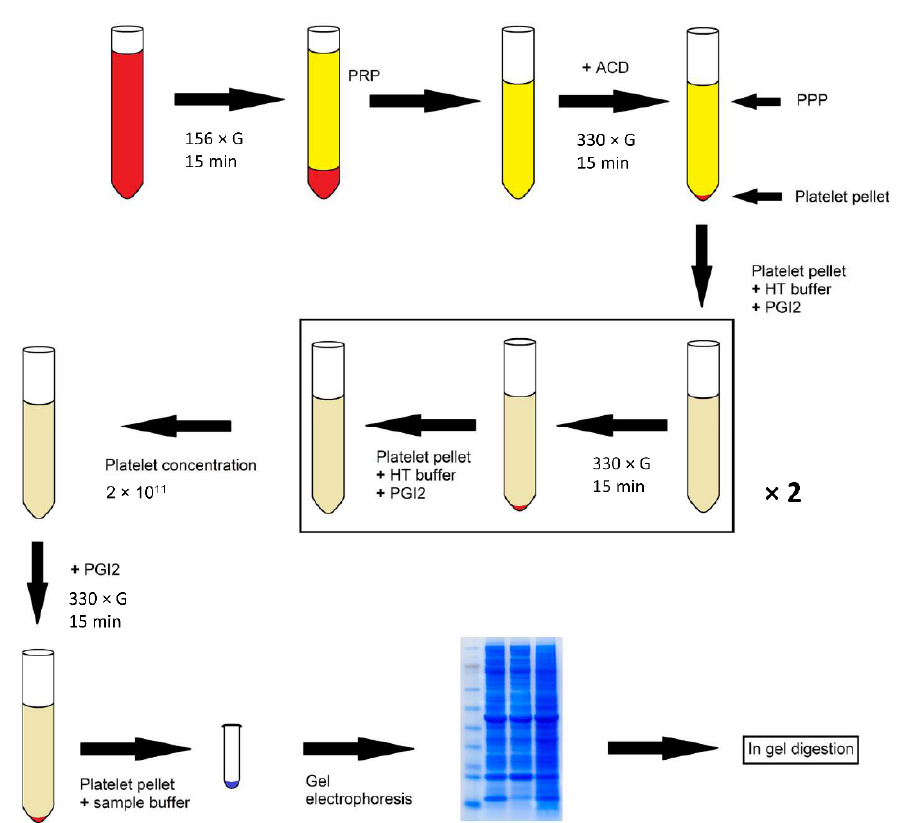
Figure 1. Schematic representation of the workflow. Blood was collected in citrated tubes. Platelet-rich plasma (PRP) was prepared by centrifugation. ACD was added, after which a platelet pellet was obtained by centrifugation. The pellet was resuspended in Hepes-Tyrode (HT) buffer (pH 6.5). Prostacyclin (PGI2) was added and a pellet was obtained by centrifugation. This was repeated once. Platelets were resuspended in HT buffer (pH 7.3). Tubes were centrifuged in the presence of PGI2. The pellet was resuspended in sample buffer, heated for 5 min at 99 ◦ C and stored at − 20 ◦ C. Proteins were separated with electrophoresis (125 V) in precast gradient gels. In-gel digestion was performed. Table 1. Characteristics of the patients and healthy volunteers. Radiofrequency ablation (RFA), radiotherapy (RT), carpal tunnel syndrome (CTS), (paroxysmal) atrial fibrillation ((P)AF), benign prostatic hyperplasia (BPH), coronary artery bypass graft (CABG), percutaneous transluminal coronary angioplasty (PTCA) (* platelet counts one day before or after collection, ** platelet counts 2.5 months before and 1.5 month after sample collection).